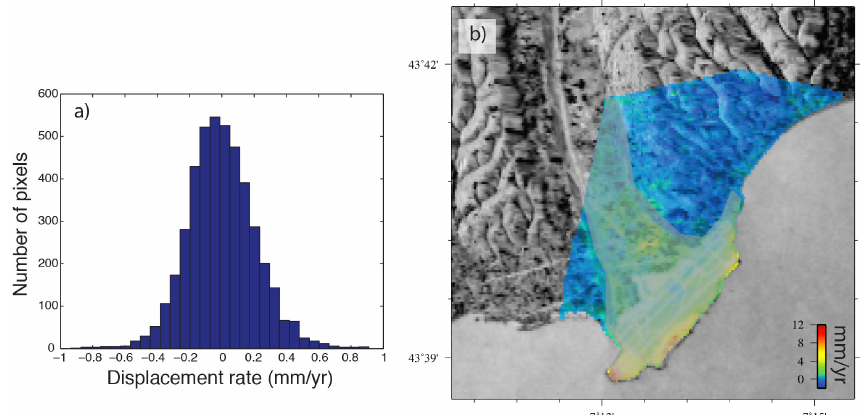
Figure 5. (a) The ground displacement rate, measured over the stable areas, shows a gaussian distribution centered around zero and with a standard deviation of 0.25mmyr − 1 . (b) Map showing in grey the area which has been masked (Var riverbed and the airport platform) to estimate the measurement